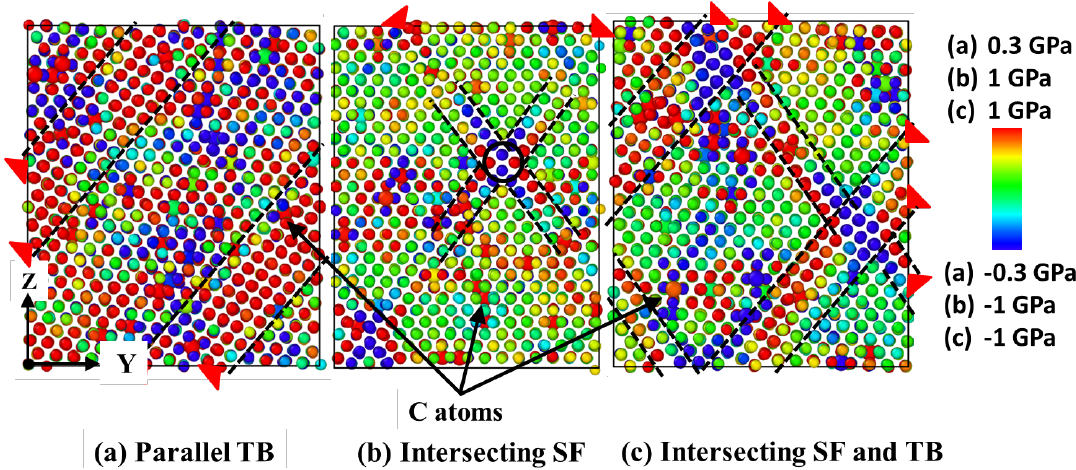
Figure 3. The resolved atomic shear stress, τ r , for different defect configurations of Fe-0.5 at. %C at 400 K. Atoms are colour coded as per τ r . ( a ) fcc phase with parallel TB, ( b ) fcc phase with intersecting SF, ( c ) fcc phase with intersecting SF and TB. The radius of C atoms is increased manually for better visibility. The red triangles indicate the original positions of SF and TB in the fcc